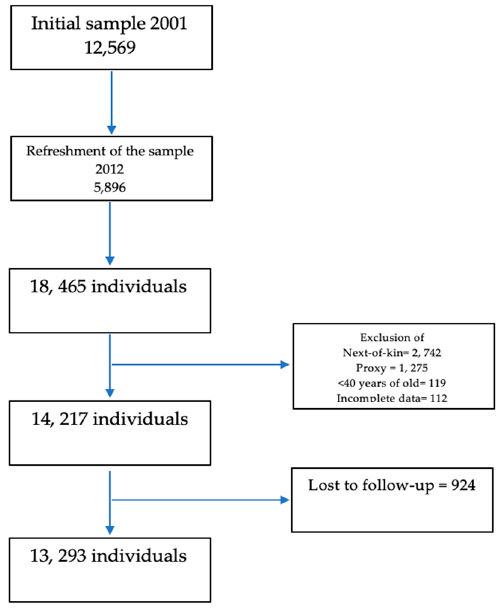
Figure 1. Sample flowchart.